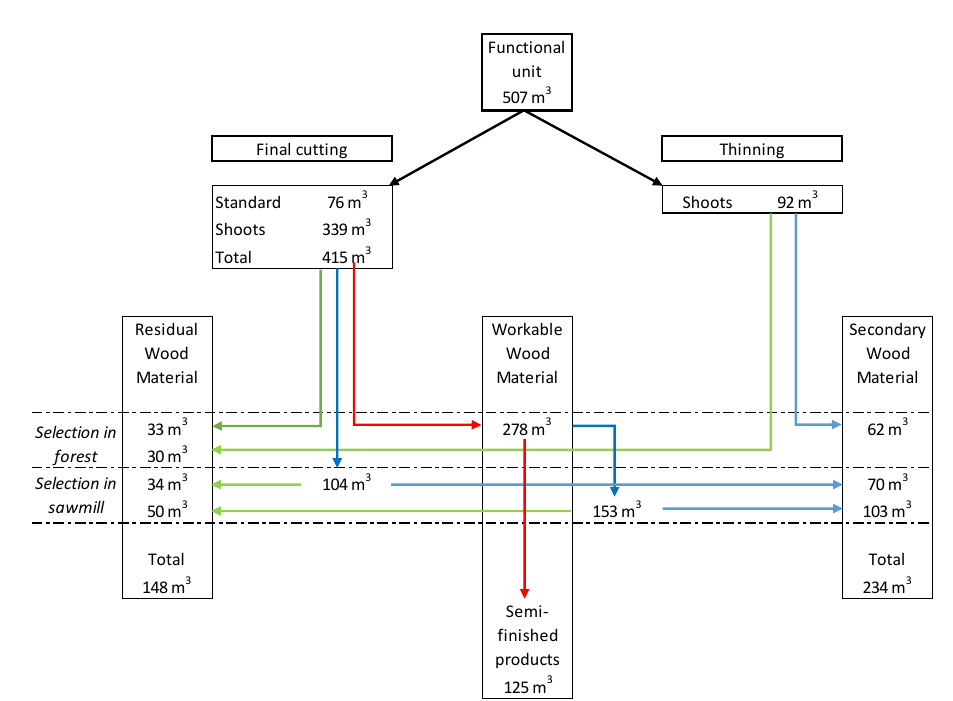
Figure 3. Functional unit and flow of raw chestnut wood material. Table 5. Chestnut timber production and volume of CO 2 stored. Legend: WWM: Workable Wood Material, MWM: Minor Wood Material. MWM WWM TotalResidual